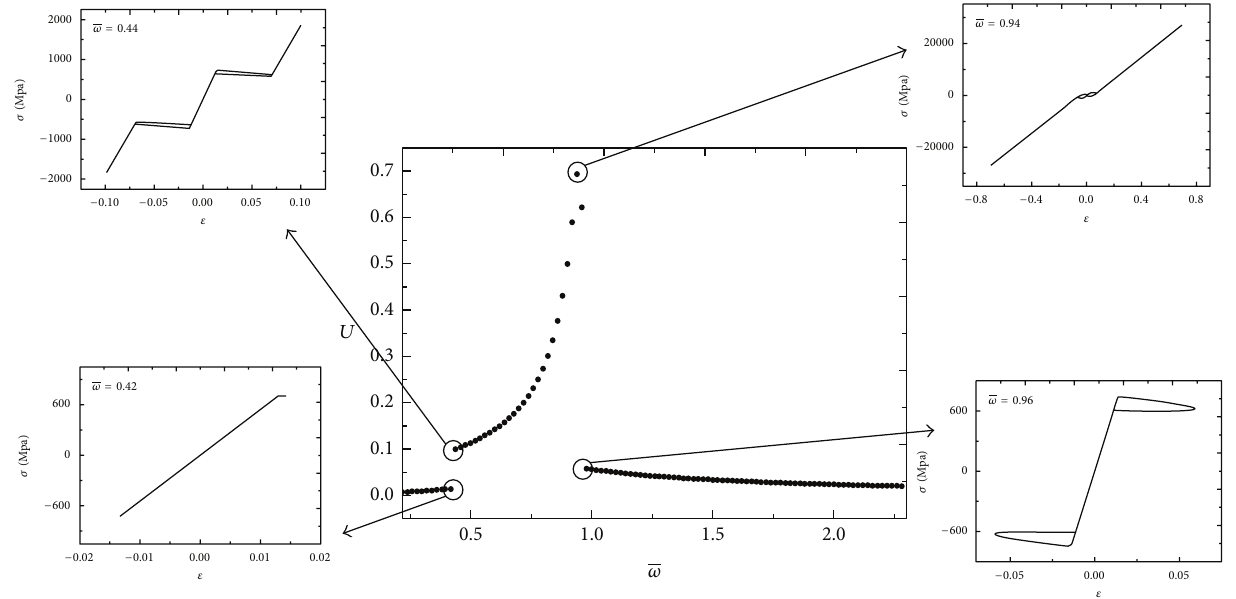
Figure 6: Up-sweep jumps with V = 0.075 m/s: comparison between frequency response and stress-strain curves.